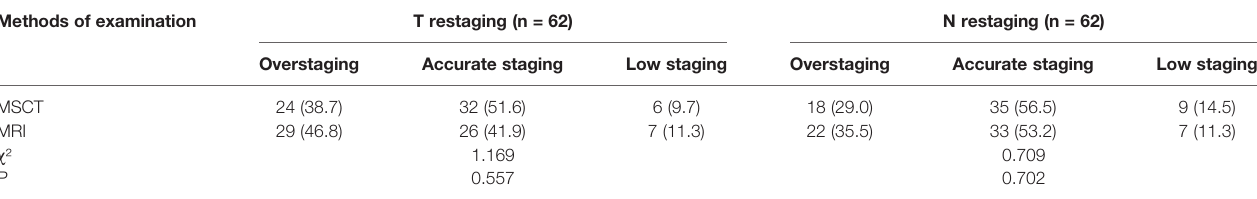
TABLE 6 | MSCT and MRI fi ndings in T and N restaging of rectal cancer after NCRT [n (%)]. Methods of examination T restaging (n = 62) N restaging (n = 62) Overstaging Accurate staging Low staging Overstaging Accurate staging Low